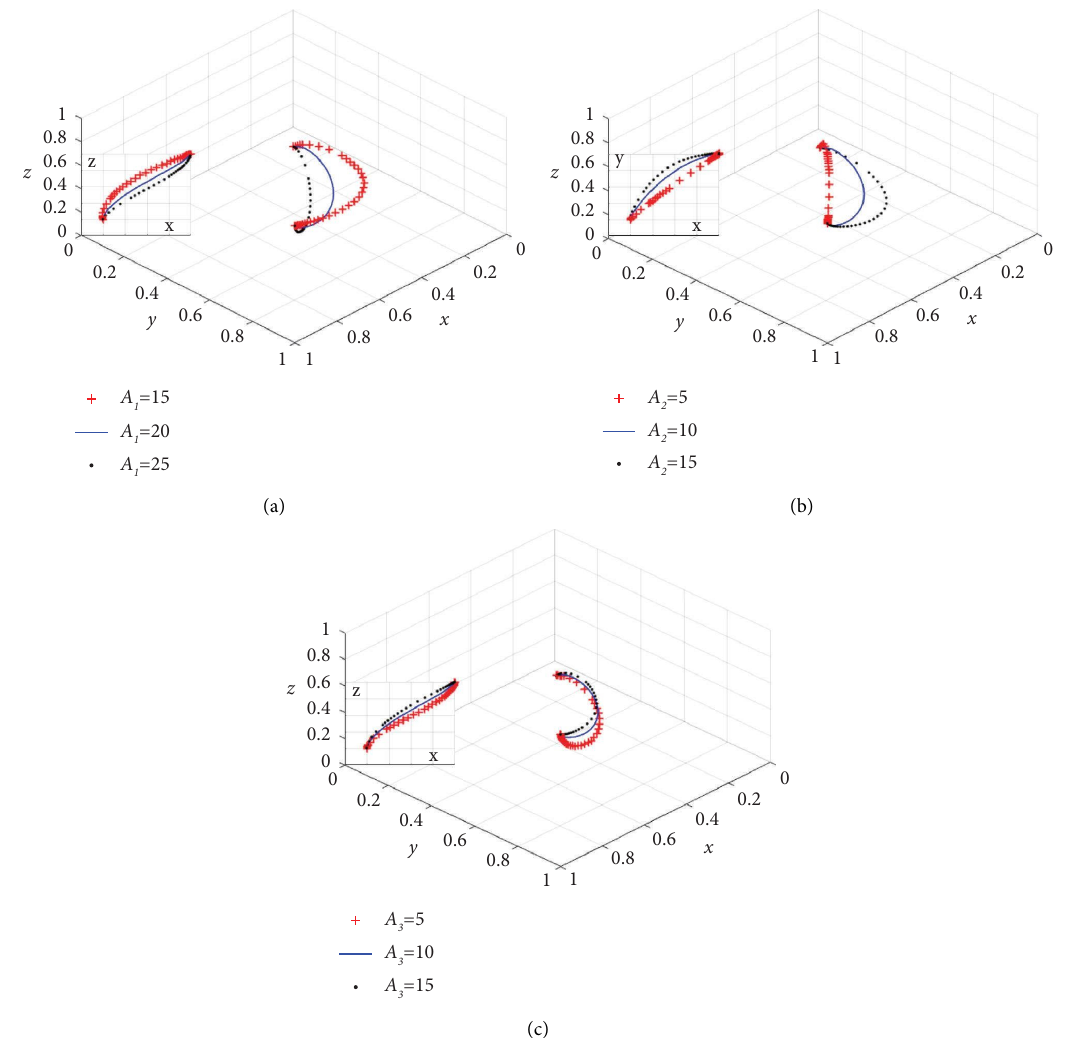
Figure 2: Sensitivity analysis of (a) A